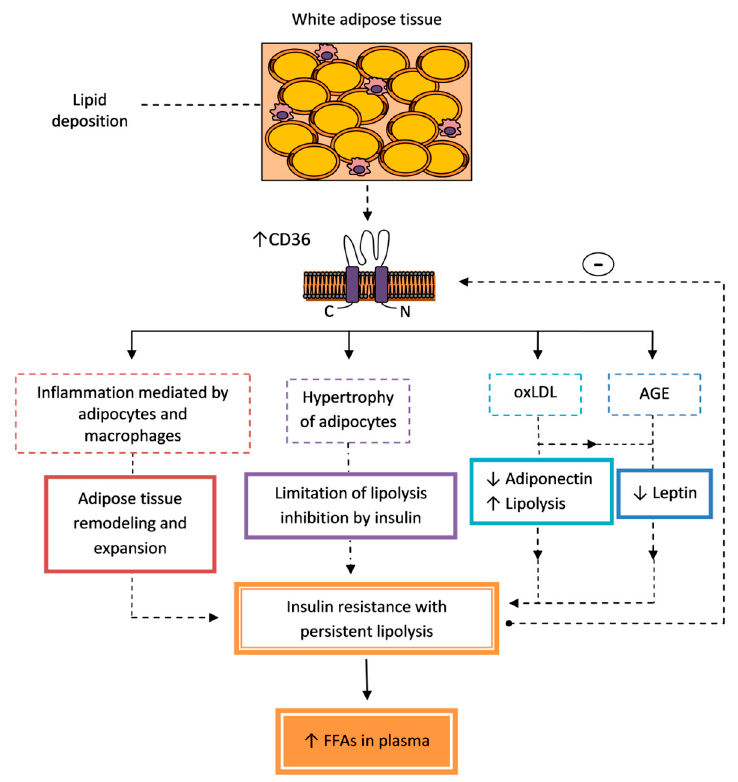
Figure 1. The contribution of CD36 to the pathogenesis of insulin resistance in adipose tissue. The roles of CD36 in the reduction of adipose tissue insulin sensitivity with increased lipolysis are to promote inflammation and promote remodeling of the adipose tissue with hypertrophy of adipocytes, and an adverse profile of adipokines mediated by oxidized low-density lipoprotein (oxLDL) and advanced glycation end product (AGE). Ultimately, this leads to a significant release of fatty acids (FAs) and an increase in free fatty acid (FFA) concentration in plasma, exceeding the energy needs of such organs as the liver, muscle, and heart.